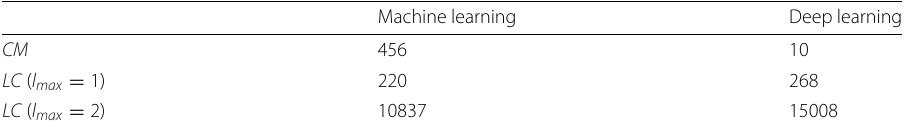
Table 3 Resulting initial candidate size per search strategy for “Machine learning” and “Deep Learning” target